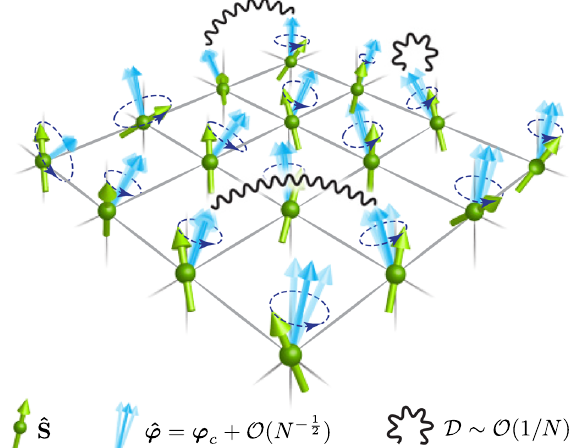
FIG. 2. The spin-2PI formalism illustrated. The spins (green arrows) precess about a fluctuating exchange field (uncertain blue arrows). The quantum fluctuations of the exchange field are mediated by real-vector bosons (wiggly lines) and are suppressed by a factor of 1 =N , permitting a systematic